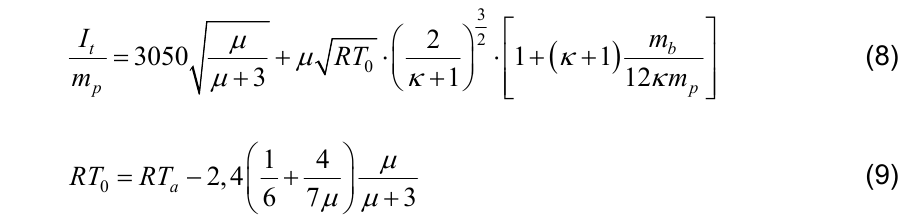
Koriste ć i relaciju (7) posle sre đ ivanja č lanova jedna č ine (5) i (6) mo- gu se sada napisati u pogodnijem obliku radi prora č una i pore đ enja sa impulsom trzanja za elektromagnetski